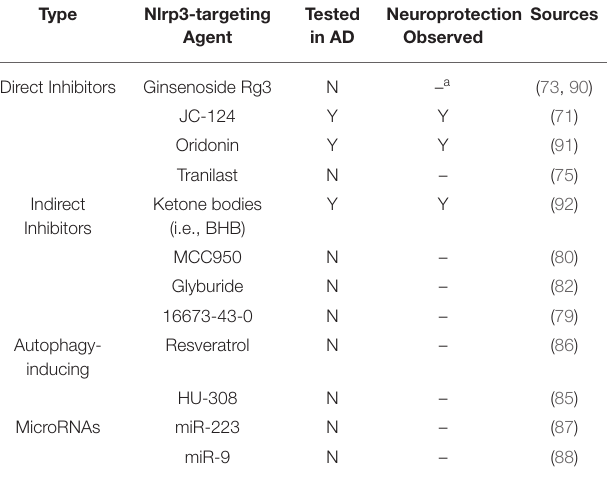
TABLE 1 | Potential inhibitors of the Nlrp3